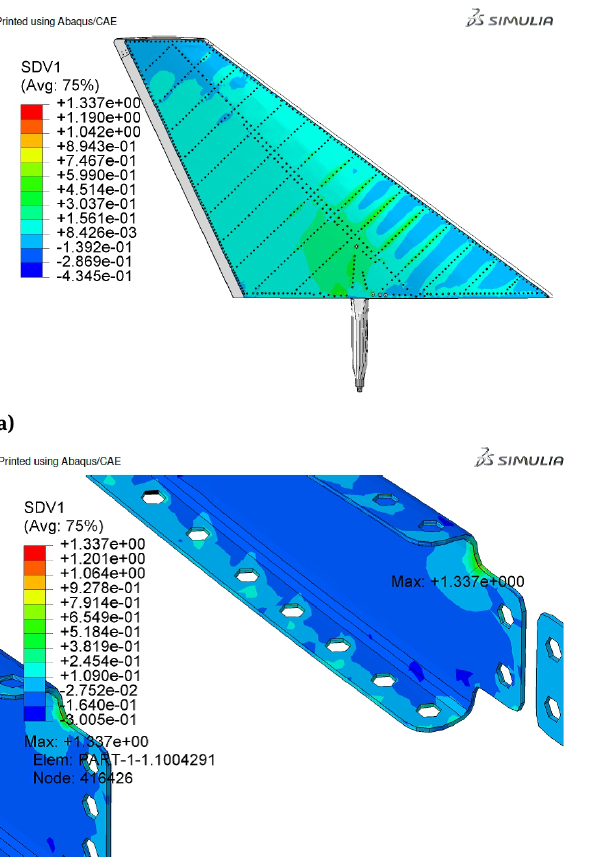
that too on negative side with use of CFC laminate. There- fore, a variation of 0.2 mm is well acceptable. The deflec- tion in z -direction is important from aerodynamics and flutter point of view while in operation. From Fig. 10(b), it can be observed that deflection of canard is reduced with implication of CFC laminate. The reduction in